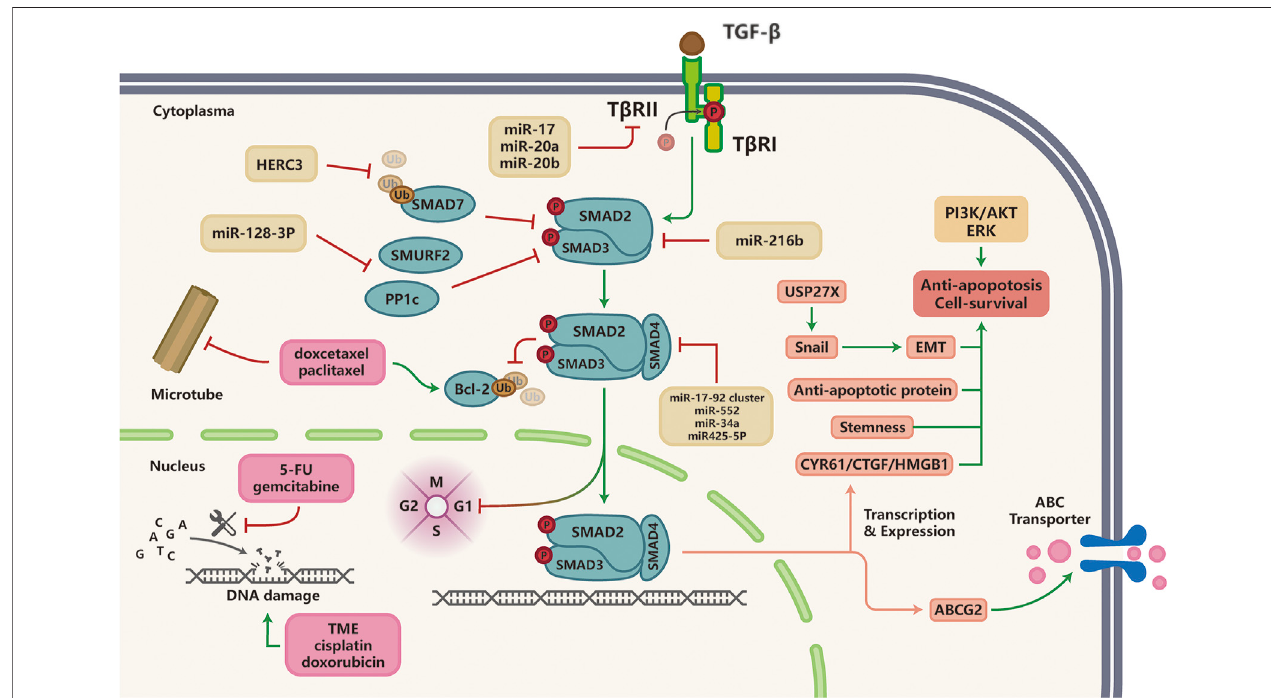
FIGURE 3 | TGF- β signaling and resistance to chemotherapy; Multiple miRNAs are implicated in TGF- β -induced chemotherapy resistance in various cancer types by targeting components of the TGF- β pathway (SMAD2, SMAD3, SMAD4). Anti-microtubule drugs promote Bcl-2 protein ubiquitination, which could be inhibited by TGF- β signaling to induce taxane resistance in malignancies. Hyperactivation of TGF- β signaling pathway induces resistance to DNA damaging agents and anti- metabolitesthroughtheactivationofalternativesurvivalpathways oranti-apoptoticsignalingsuchasPI3K/AKTandERKpathways, aswellaselevated expression of ABC multi-drug transporters to facilitate cancer cell survival and drug ef fl ux,